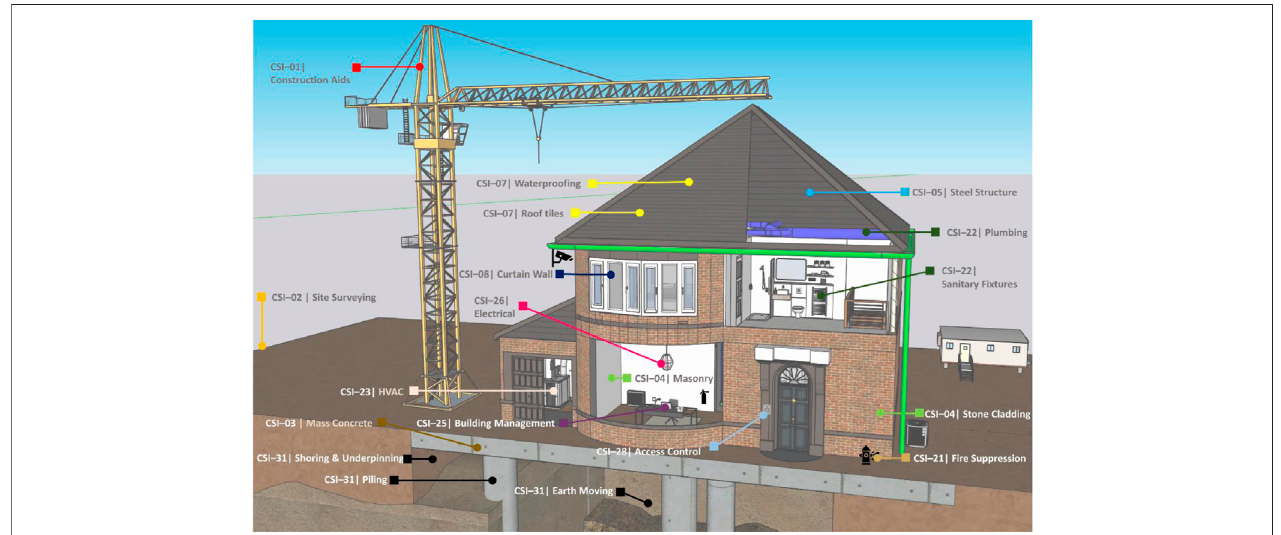
FIGURE 3 | Visual representation on some Digital Twin applications shared by